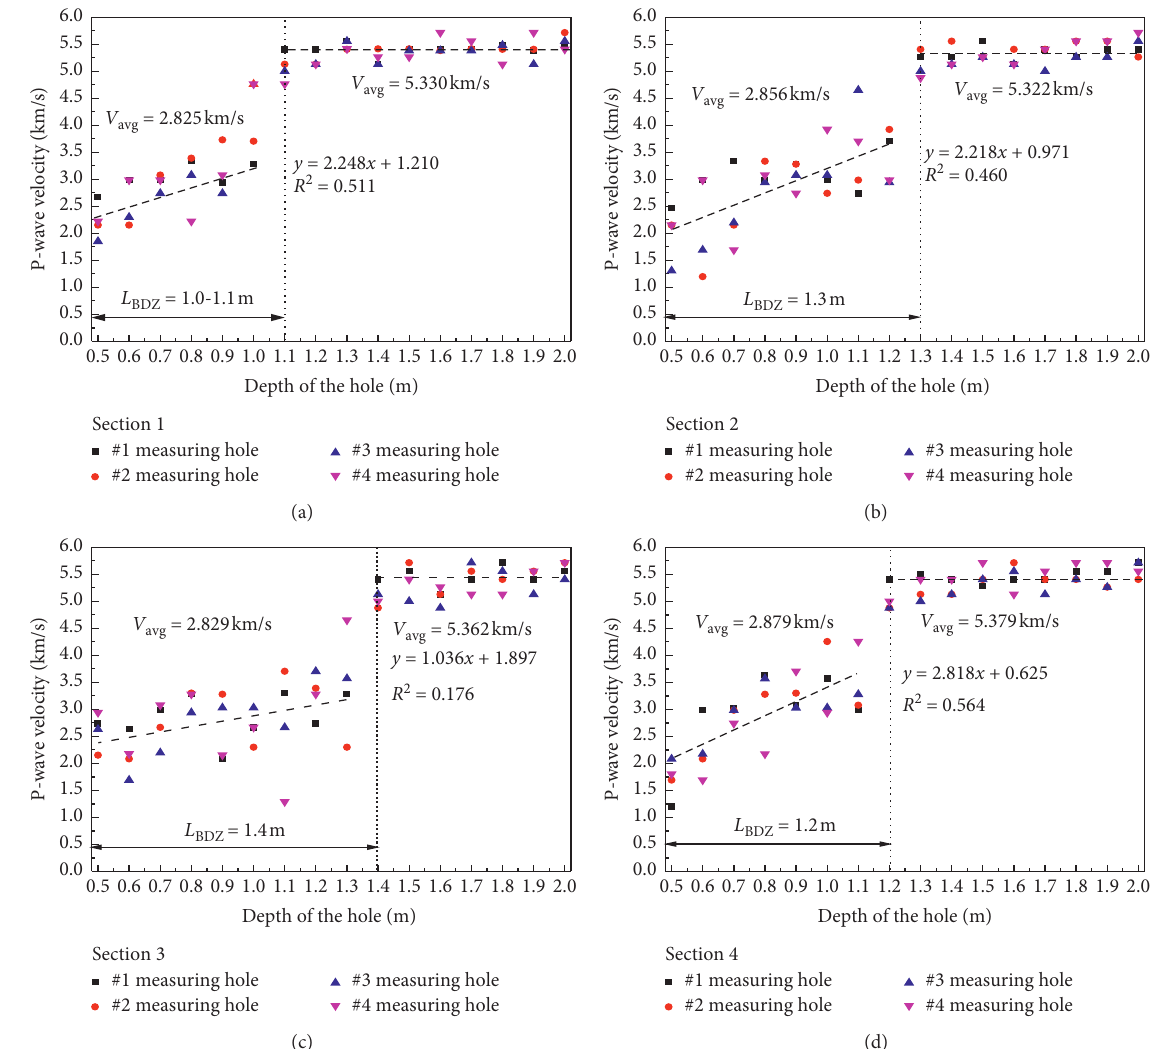
Figure 9: P-wave velocity ( V p ) in the test holes: (a) section 1; (b) section 2; (c) section 3; (d) section